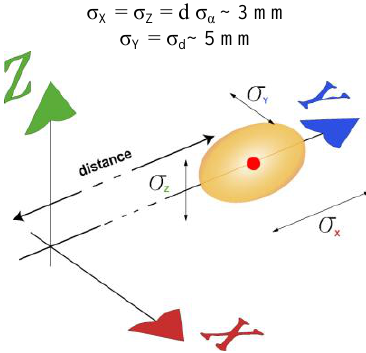
Figure 4. The accuracy of laser scanner is composed of a combination of errors in distance and angles measurements.